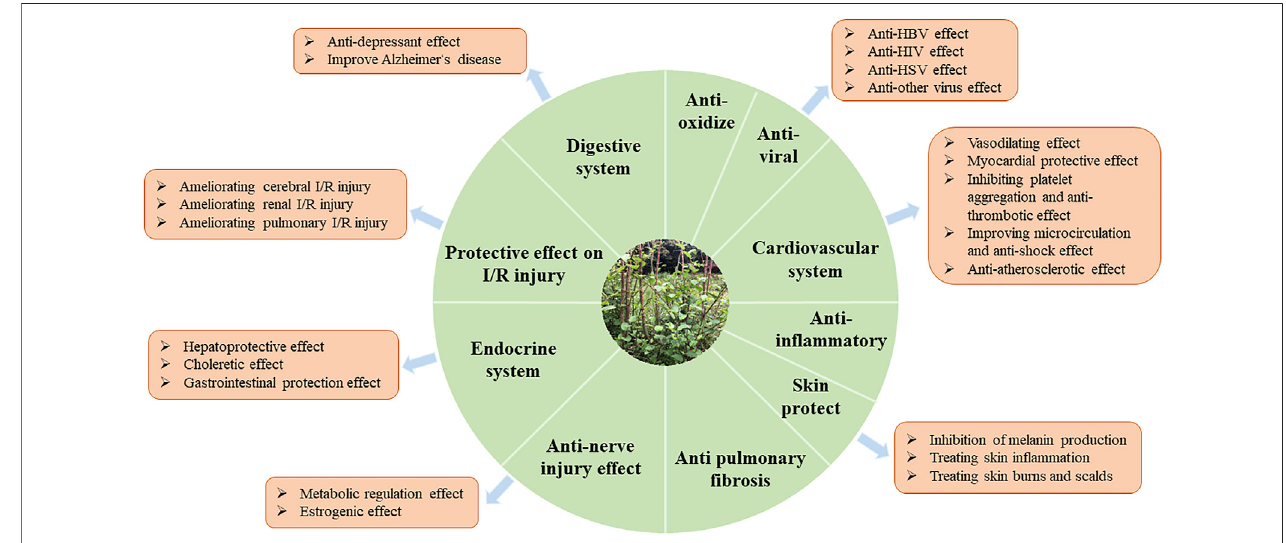
FIGURE 9 | Biological activities of Reynoutria japonica Houtt.